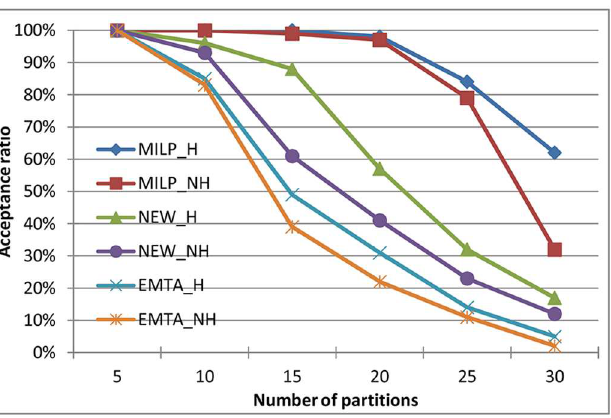
Fig 6. Acceptance ratios of MILP formulation, our approach and EMTA algorithm on partitions with harmonic and non-harmonic periods.